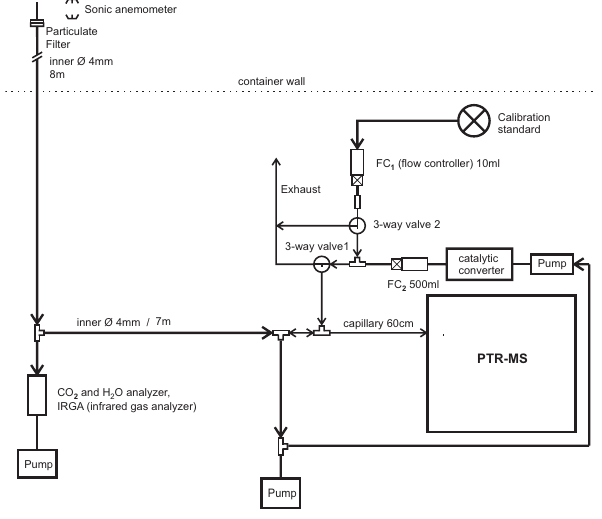
Fig. 2. Schematical drawing of the PTR-MS inlet system and setup. During ambient air measurements outside air is drawn from the in- let line into the PTR-MS. For background measurements valve 2 is switched on and scrubbed ambient air obtained from a catalytic converter is guided to the instrument. For calibration measurements valve 1 is switched on to mix the selected gas standard flow (FC 1 ) with the scrubbed ambient air (FC 2 set to